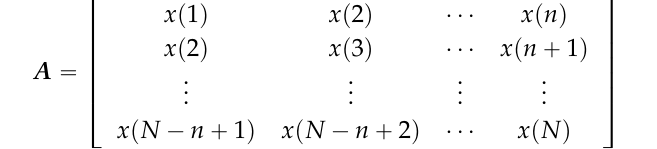
Figure 5. Procedure of the conventional SVD de-noising method.